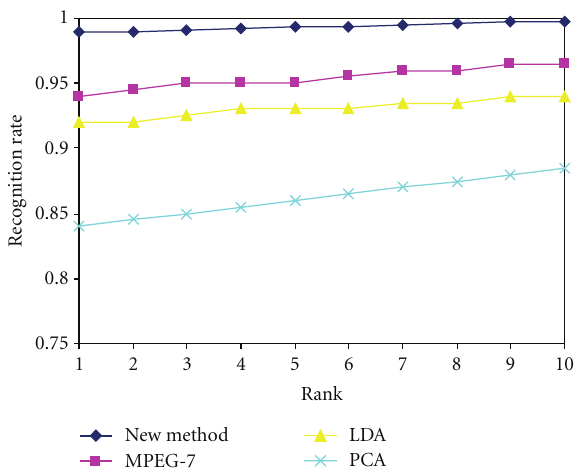
Figure 7: CMS results for the FERET (Fb) database.